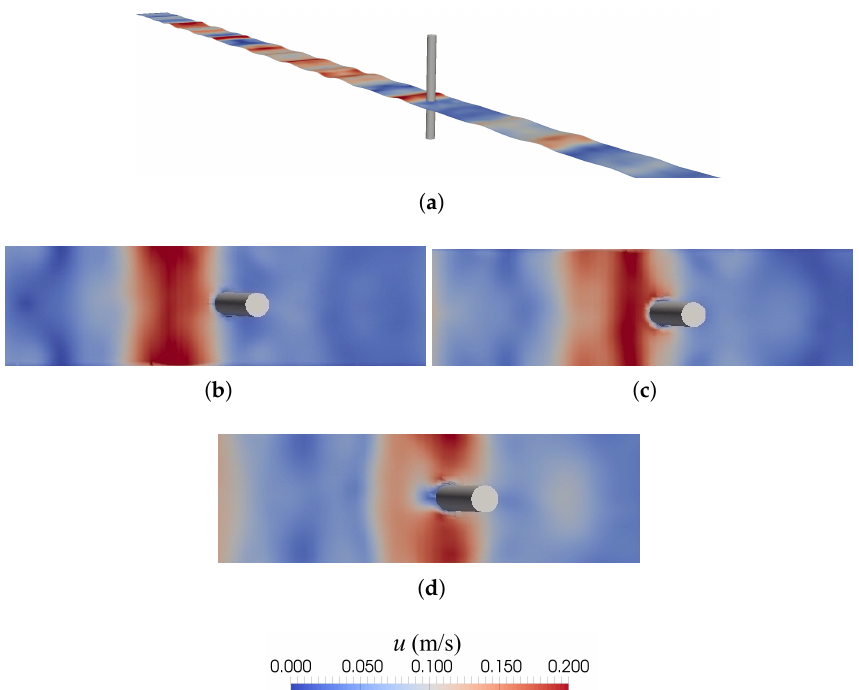
Figure 14. Snapshots of numerically reconstructed irregular wave crest interacting with the cylinder ( a ), t = 30.42 s, in three-dimensional view; ( b ) before the cylinder, t = 30.42 s (top-view); ( c ) next to the cylinder, t = 31.15 s (top-view); ( d ) besides the cylinder, t = 31.58 s